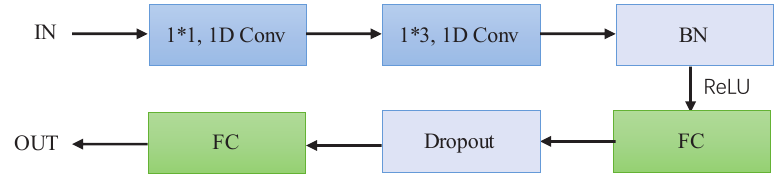
Figure 7. Implementation process of the physiological feature extraction